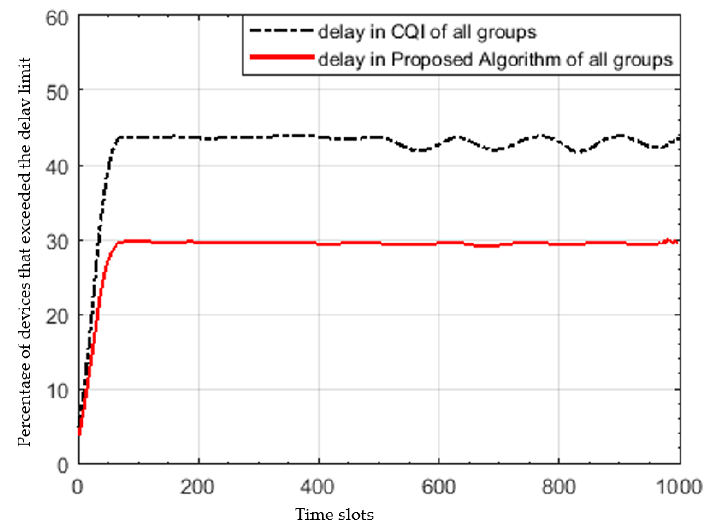
Figure 5. Percentage of devices exceeding the application delay limit at each time slot.